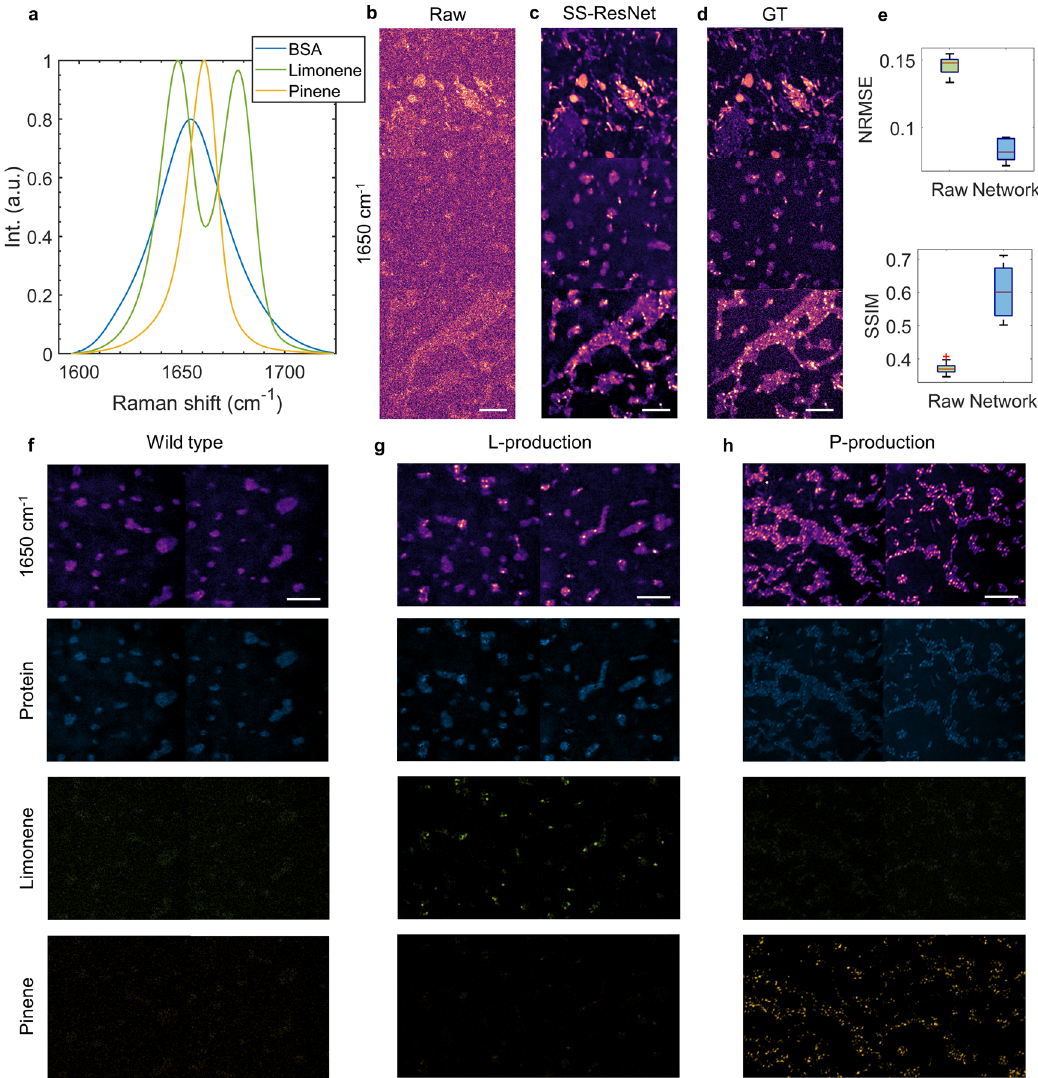
Fig. 4 High-speed imaging of E. coli biofuel production strains. a Fingerprint SRS spectra of bovine serum albumin (BSA), pure limonene, and pinene samples. Int., intensity. a.u., arbitrary unit. b – d Fingerprint spectroscopic SRS imaging of E. coli by single raw acquisition, spatial-spectral residual net (SS- ResNet) recovery from raw data, and 100 averaging ground truth (GT). e Quantitative analysis of network recovery quality for the E. coli dataset. Box plots ( n = 13) show the NRMSE and SSIM for raw vs. GT and network vs. GT. The boxes show interquartile range (IQR), the red line indicates medians, the black lines represent whiskers which extend to 1.5 times of the IQR and the red data points are the outliers exceeding the whiskers. NRMSE normalized root mean square error, SSIM structural similarity index. f – h Network-recovered image at 1650 cm − 1 and chemical mappings of protein, limonene, and pinene for wild type, limonene production, and pinene-production strains. L-production, Limonene production. P-production, Pinene production. Scale bars, 10 µ